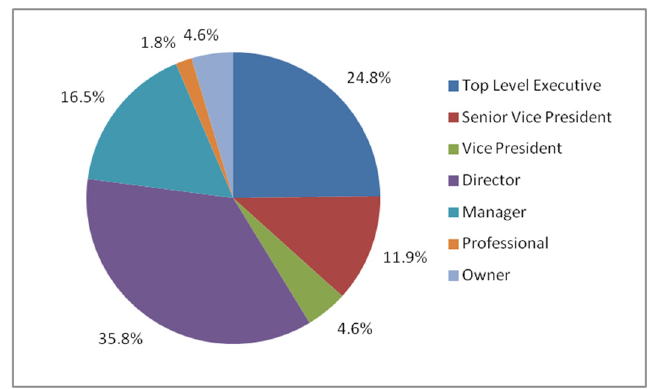
Figure 17. Respondents’ Job Profile.